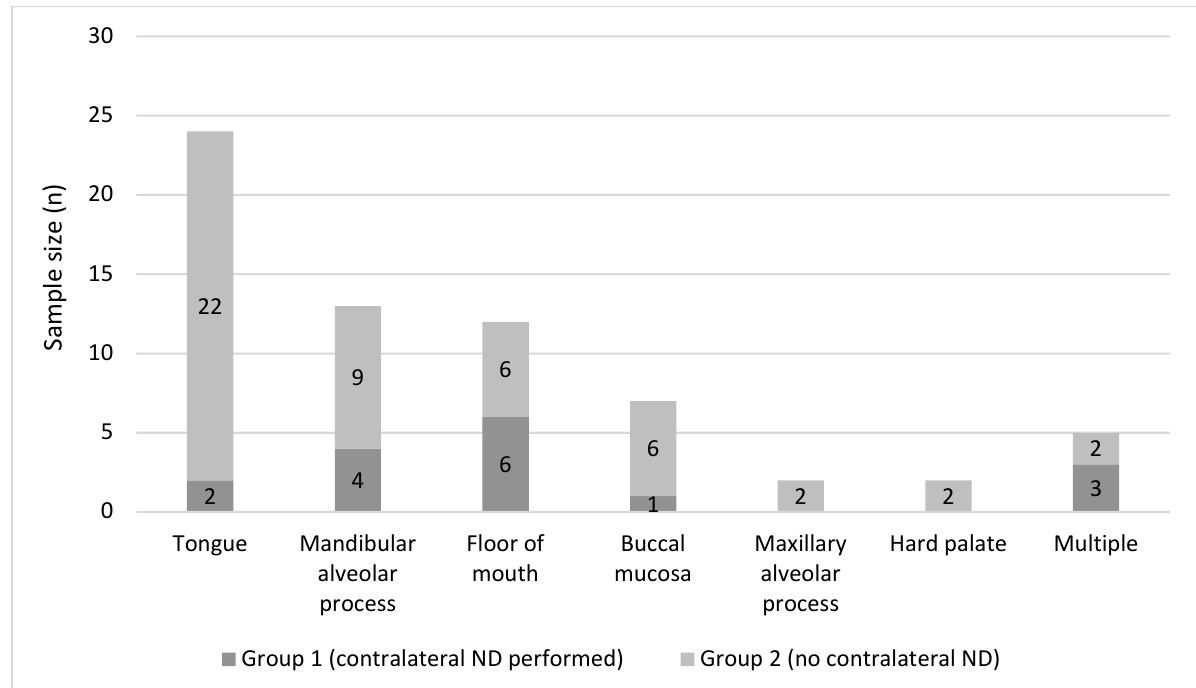
Figure 2. Distribution of primary tumor sites between both groups.